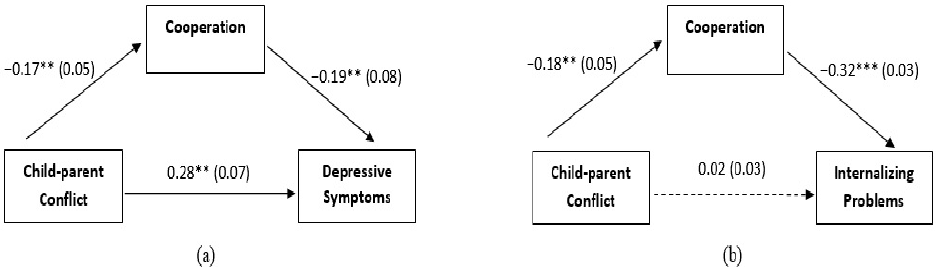
Figure 2. Cooperation as mediator of the association between Child–parent Conflict and Depressive Symptoms ( a ) and Internalizing Problems ( b ). Unstandardized coefficients are reported with standard errors in parentheses. Both models include Gender as a covariate of Cooperation. Analyses were based on 5000 bootstrap samples with 95% bias-corrected confidence intervals; ** p < 0.01; *** p < 0.001.